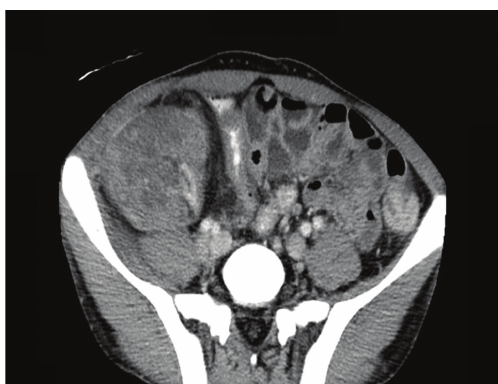
Figure 1: Computed tomography scan showing hyperdense areas in the renal allograft, in keeping with foci of parenchymal haemor- rhage.